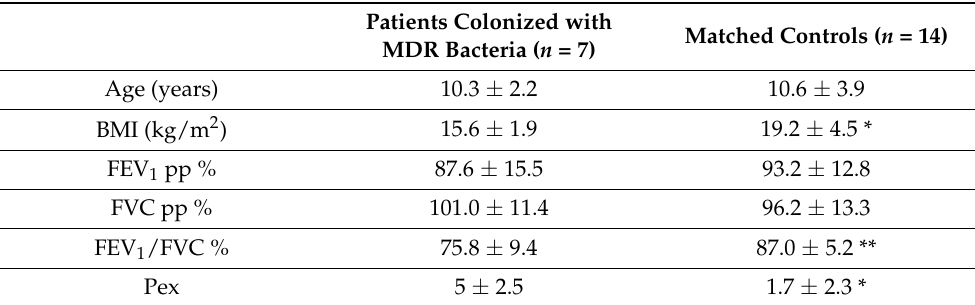
Table 2. Characteristics and pulmonary function tests in the year before the first detection of MDR bacteria in MDR group and in control